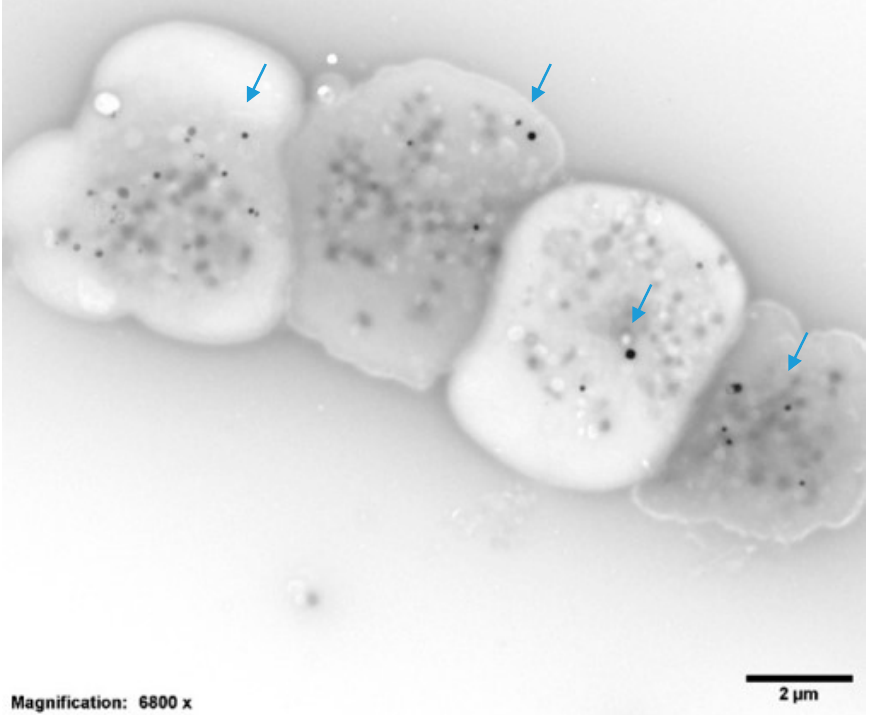
Figure 2. Representative transmission electron microscopy image of four (4) whole-mounted and air-dried platelets. Dense granules appear as opaque round bodies (arrows; normal = 4–6/platelet; range 0–30/platelet), whereas the ill-defined gray bodies are alpha granules (50–80/platelet).